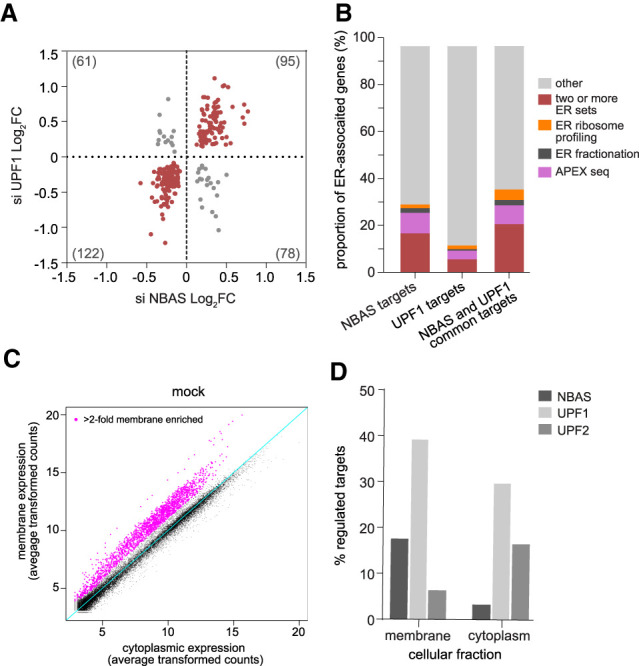
NBAS-regulated targets are enriched for ER-localized transcripts. (A) Scatter plot of differentially expressed transcripts shows a significant positive correlation between NBAS and UPF1-regulated targets (Pearson's correlation r = 0.67; P < 0.0001). Numbers in brackets indicate the number of regulated transcripts in each quadrant. (B) NBAS-regulated targets are enriched for experimentally identified ER-localized transcripts. Bar charts show the proportion of targets that are ER-localized by APEX-seq, ER fractionation, and ER proximity-specific ribosome profiling. The ER enrichment of NBAS targets is significantly higher than that of UPF1 targets (P < 0.0001, exact binomial test), whereas the difference between NBAS targets and NBAS-UPF1 common targets is not statistically significant (P = 0.1867, exact binomial test). (C) RNA-seq of samples from subcellular fractions (membrane and cytoplasm) allows identification of membrane-associated genes. Scatter plot shows average transformed counts of each gene in membrane and cytoplasmic fractions in mock-depleted cells. (D) NBAS preferentially regulates membrane-associated targets. Plot shows percentage of “membrane-associated” genes in the membrane fraction and of “nonmembrane” genes in the cytoplasm that are regulated (P < 0.05) by each NMD factor. NBAS regulates over fivefold higher percentage of membrane-associated genes than nonmembrane genes (P < 0.001, exact binomial test). In contrast, UPF1 regulates a similar percentage of both membrane-associated and nonmembrane genes (1.3-fold higher percentage of membrane-associated genes, P < 0.001, exact binomial test), and UPF2 regulates 2.5-fold higher percentage of nonmembrane genes than membrane genes (P < 0.001, exact binomial test).